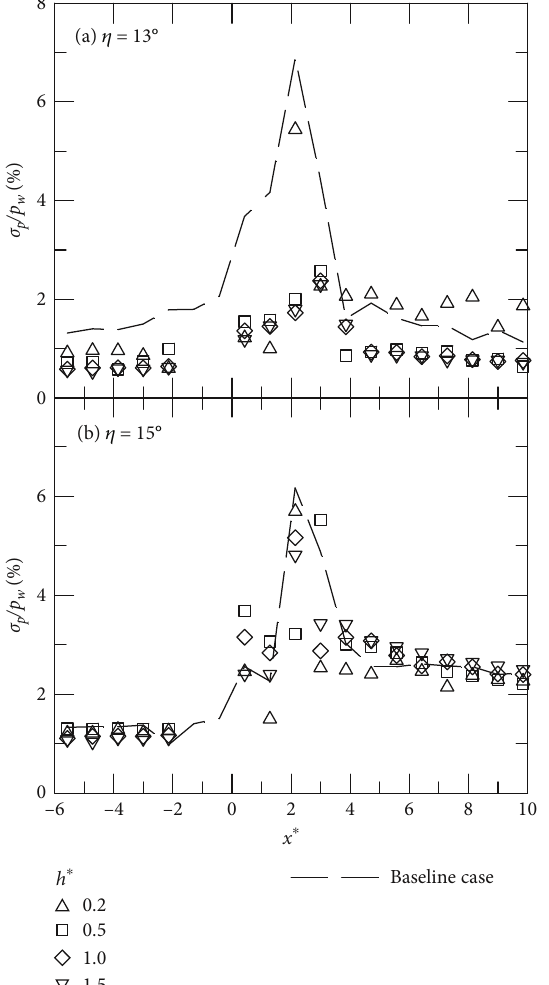
Figure 9: The e ff ect of h ∗ on peak pressure fl